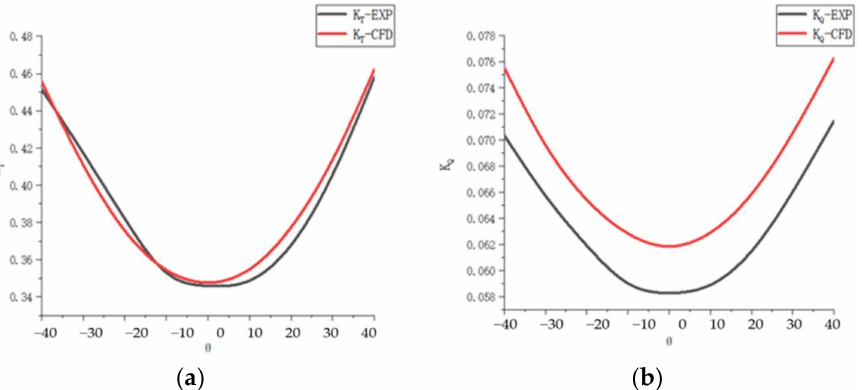
Figure 11. Comparison of podded propeller hydrodynamic performance: ( a ) Thrust coefficients ( b ) Torque